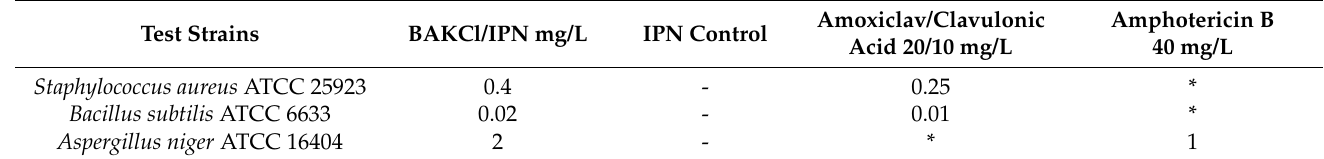
Table 1. MIC of the used antimicrobial agent (BAKCl/IPN) against opportunistic test bacteria and fungi. Test Strains